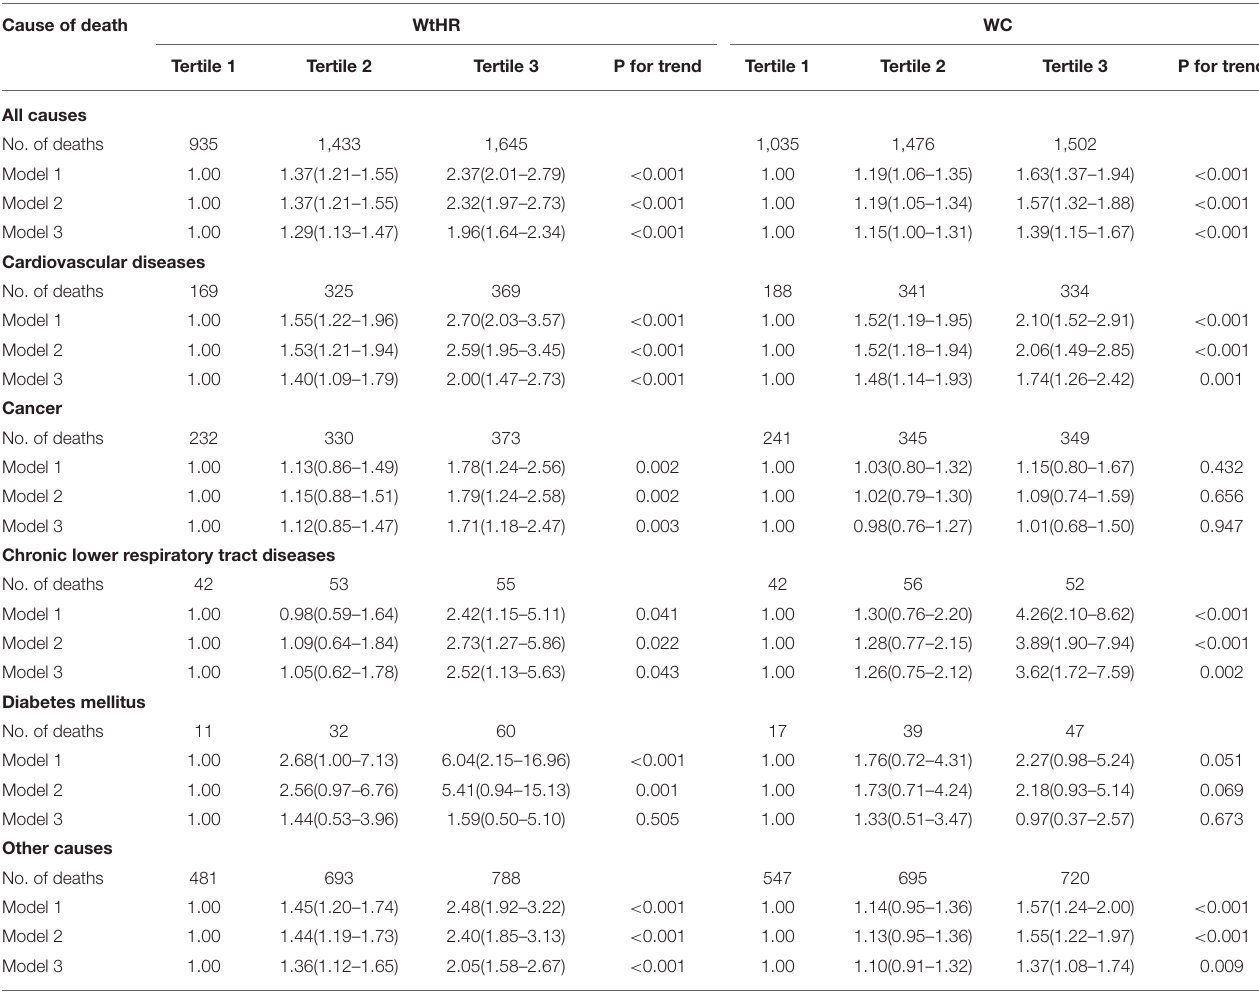
TABLE 2 | Associations between the WtHR and WC with all-cause and cause-specific mortality. Cause of death WtHR WC Tertile 1 Tertile 2 Tertile 3 P for trend Tertile 1 Tertile 2 Tertile 3 P for